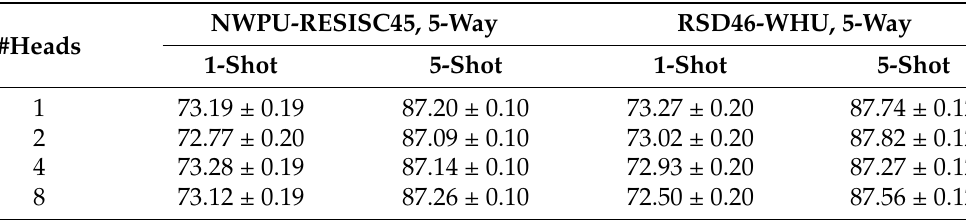
Table 8. Ablation study on the number of attention heads in the proposed embedding adaption module. Results are averaged over 10,000 test tasks with 95% confidence intervals.